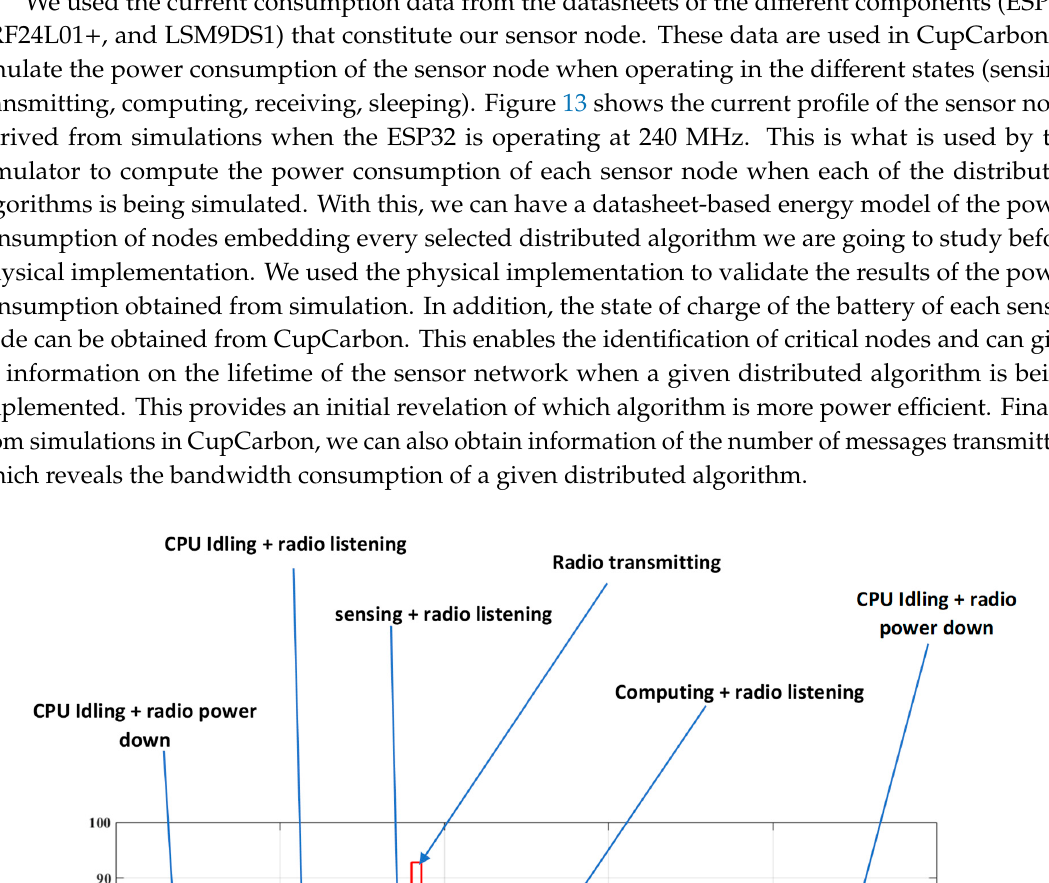
Table 3. Simulated current consumption of the sensor node at different states.